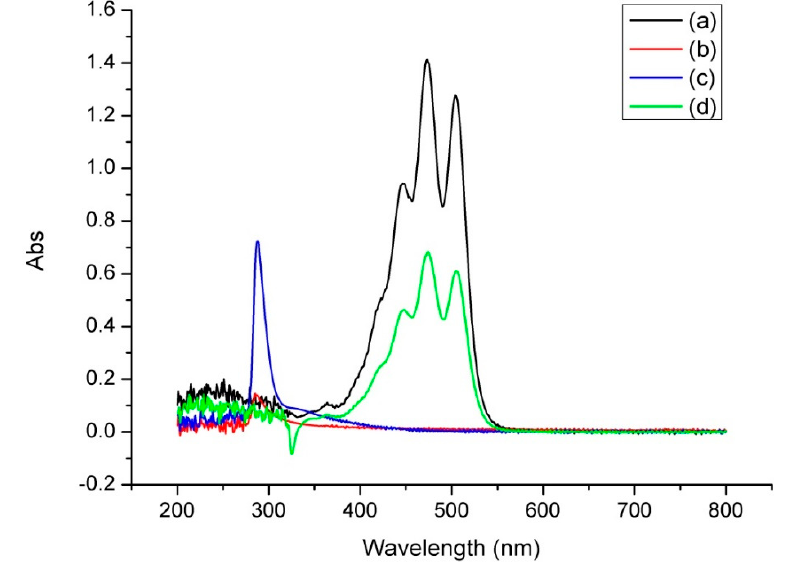
Figure 3. UV spectra of lycopene ( a ), β -CD ( b ) and inclusion complexes (aqueous solution ( c ), extracted with acetone ( d )).